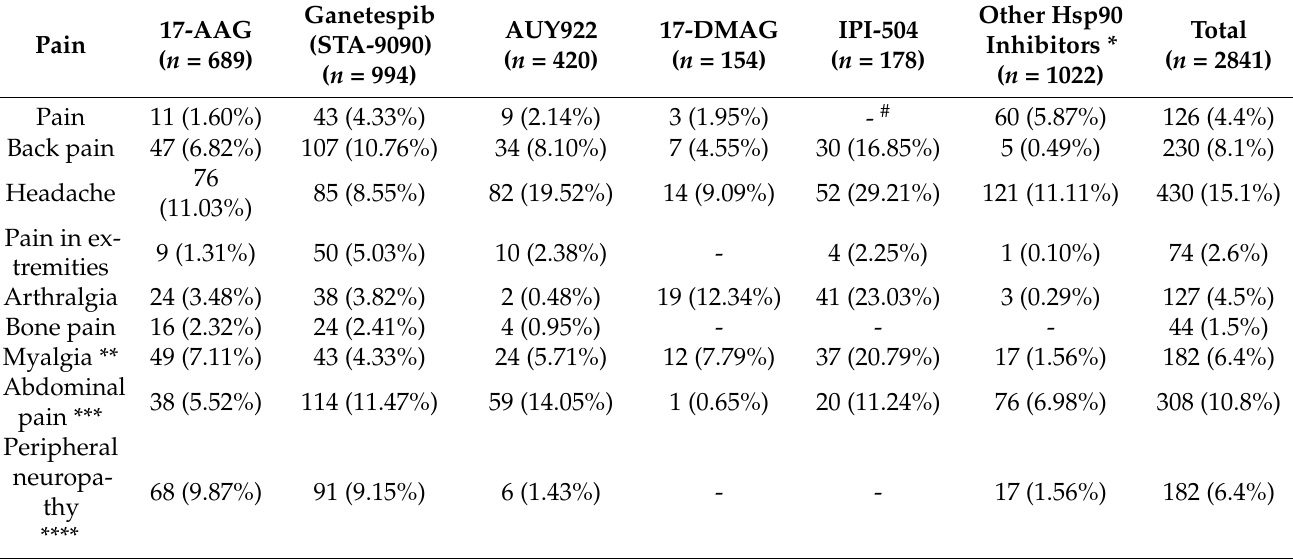
Table 1. Summary of pain in Hsp90 inhibitor clinical